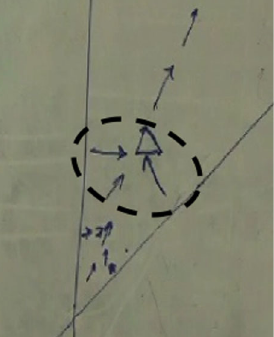
FIG. 4. Jim ’ s electric field vector map for two charged infinite sheets. The long lines represent the charged sheets. Jim first drew the arrows (circled) representing the electric fields from each sheet and then he added them head to tail as shown. Then he drew the other arrows (outside our circle) representing the combined electric field due to the two sheets. The smallest arrows lie closest to the intersection, and the arrows nearest the sheets are perpendicular to the